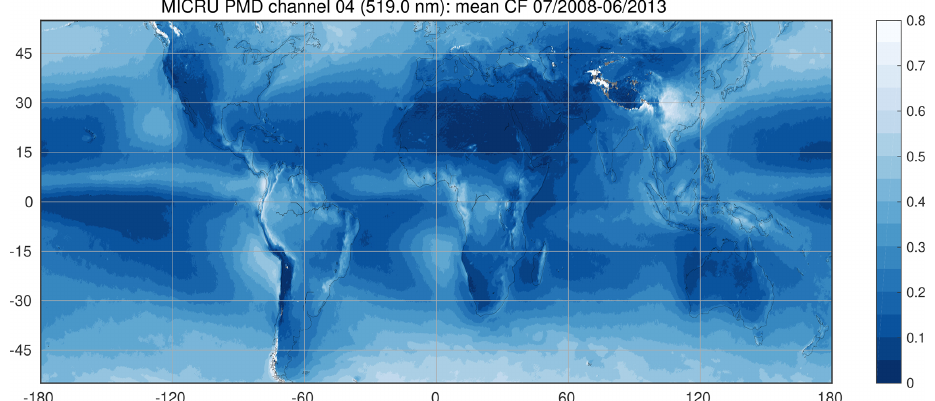
Figure F8. Same as Fig. 14 but showing the 5-year average of the MICRU PMD channel 4 cloud fraction measurements recorded between 1 July 2008 and 30 June 2013. Areas without data are plotted in